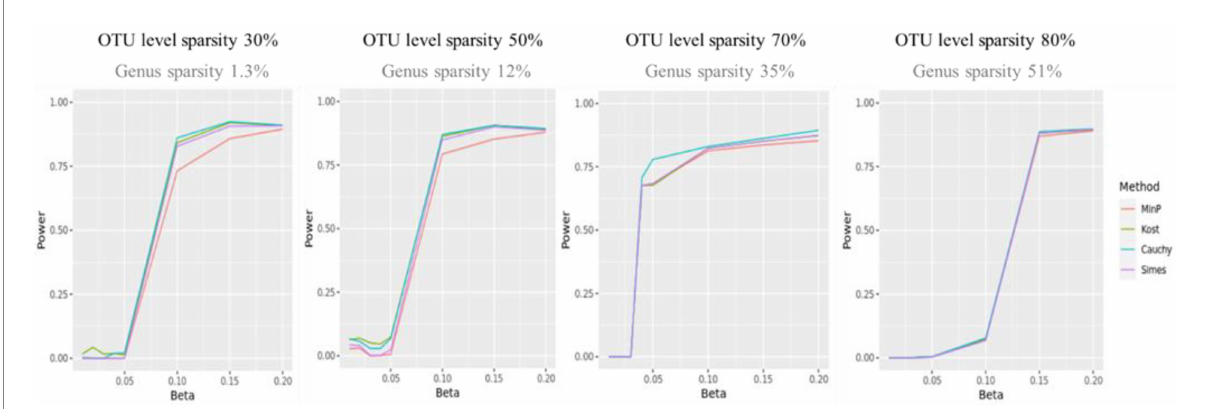
FIGURE 3 The statistical power of value of p combination methods. The x -axis represents the degree of association ( β ). The value of s β were given as